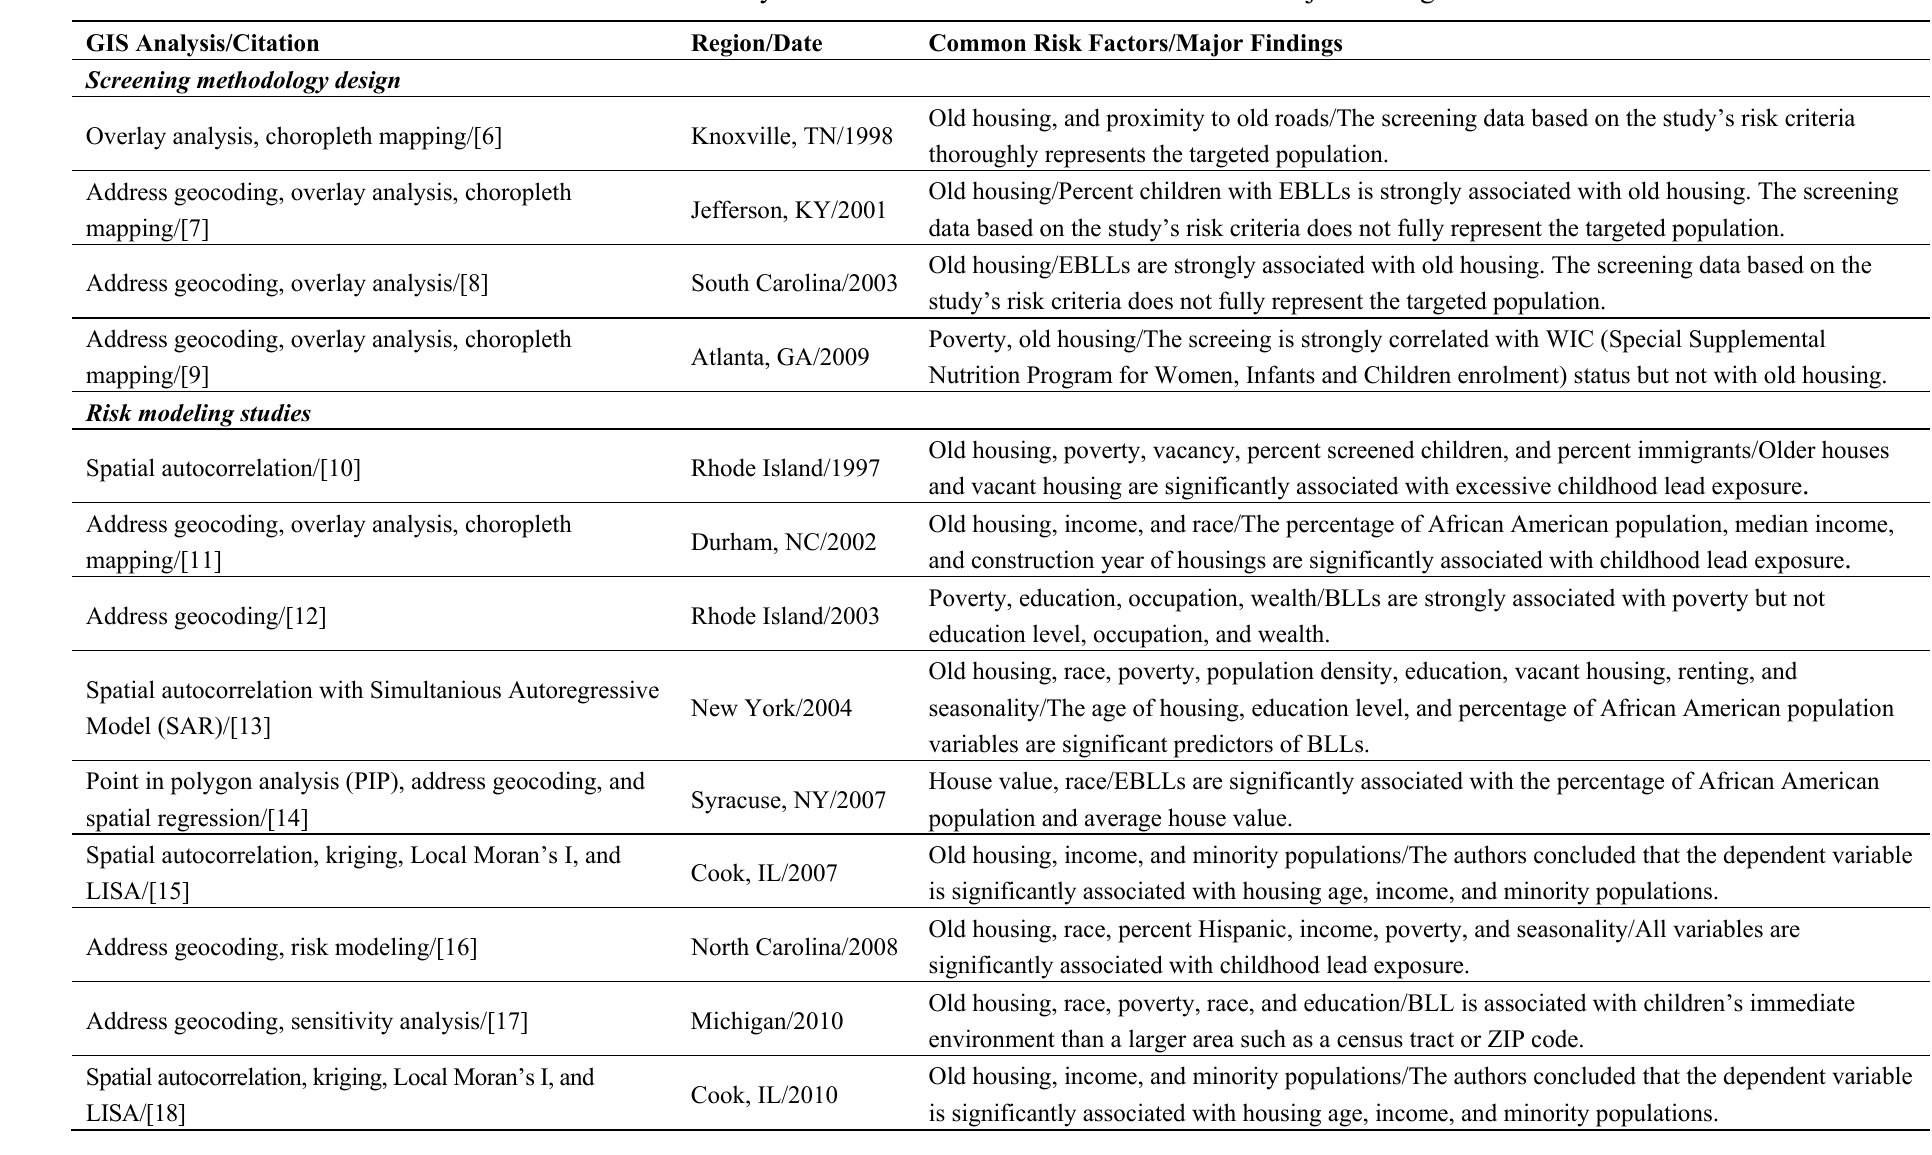
Table 1. Summary of studies with common risk factors and major